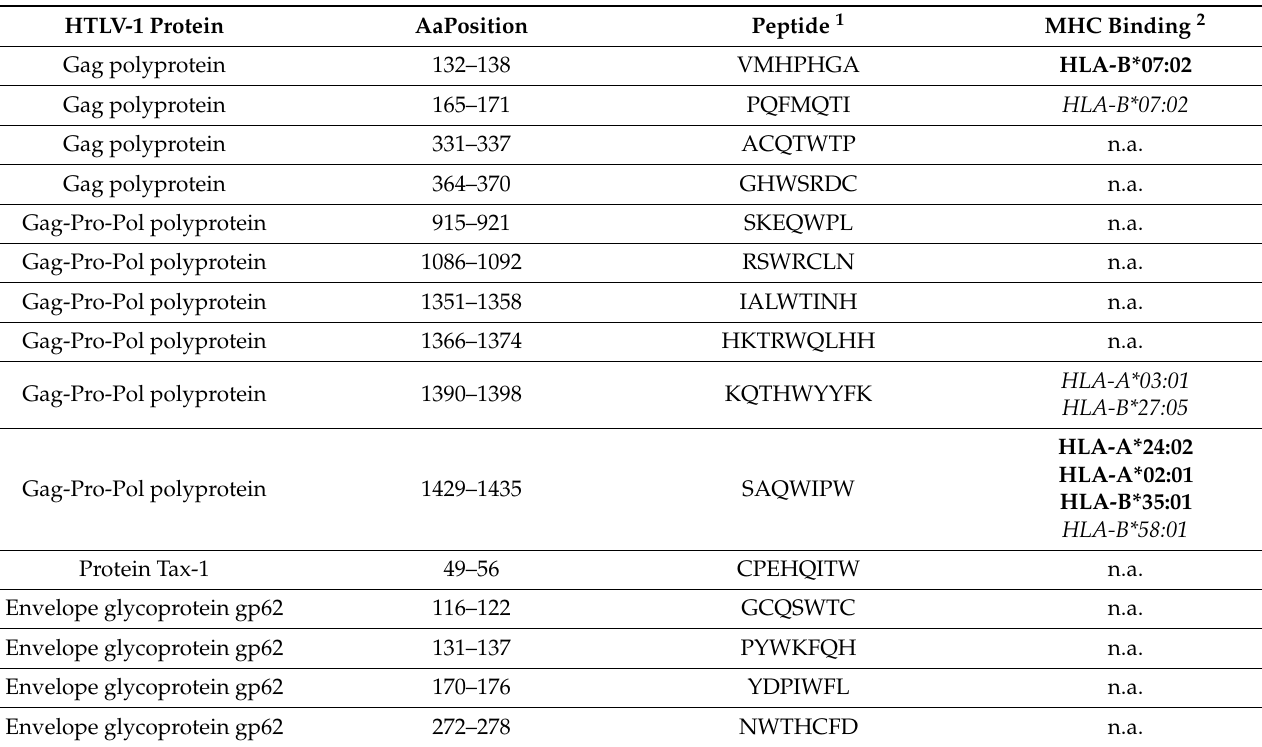
tential as follows. HTLV-1 derived epitopes were retrieved from IEDB, and the epitopes